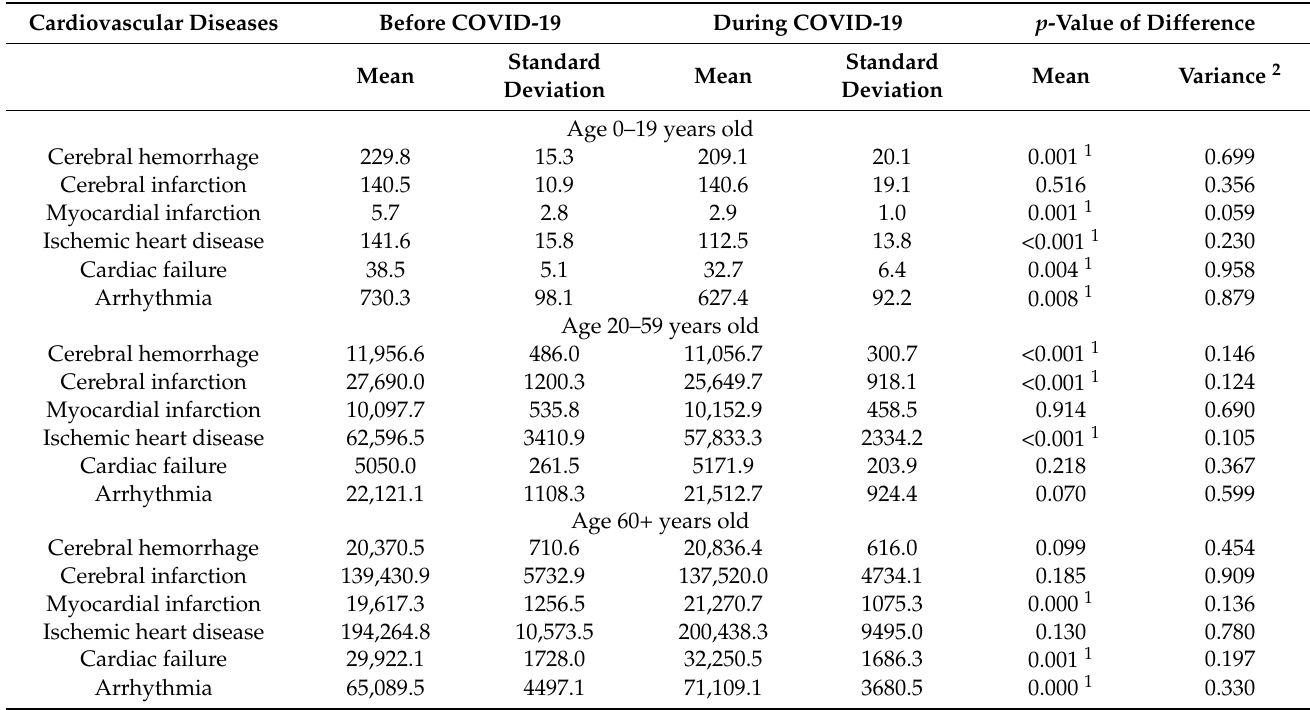
Table 3. Mean and standard deviation of the monthly incidence in six cardiovascular diseases before and during the COVID-19 pandemic stratified by sex in subgroup